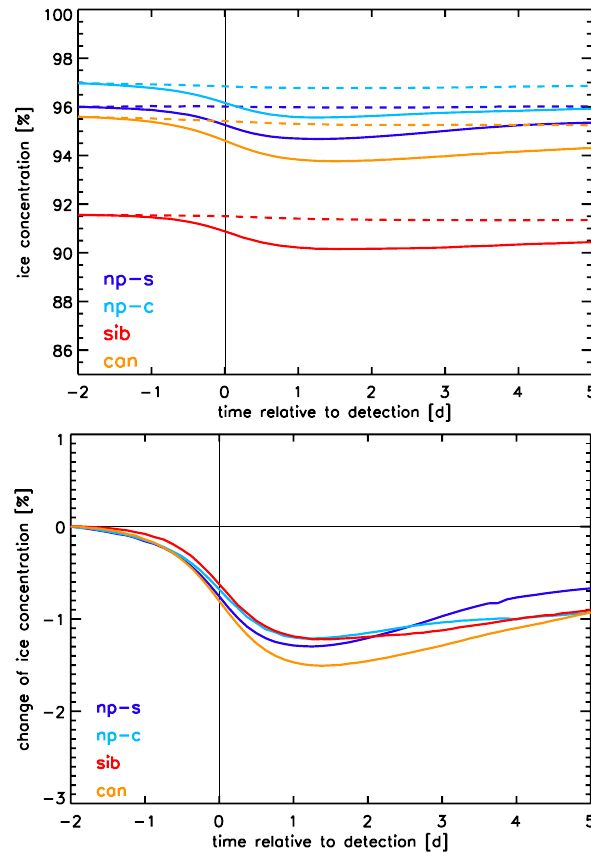
Fig. 15. As in Fig. 12, but for different sub-regions of the Arctic